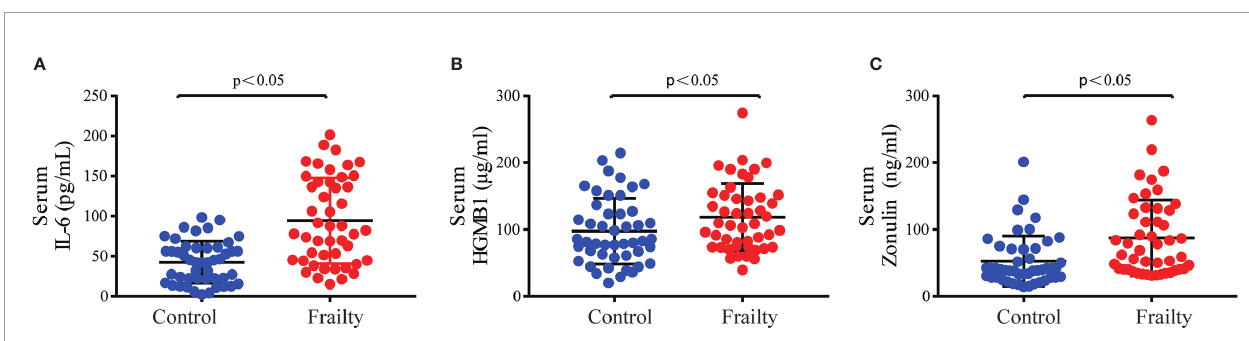
FIGURE 1 | Serum in fl ammatory cytokine concentrations of (A) IL-6 and (B) HMGB1 and intestinal permeability biomarker (C) zonulin among older adults with frailty and healthy controls. * P < 0.05 for differences between